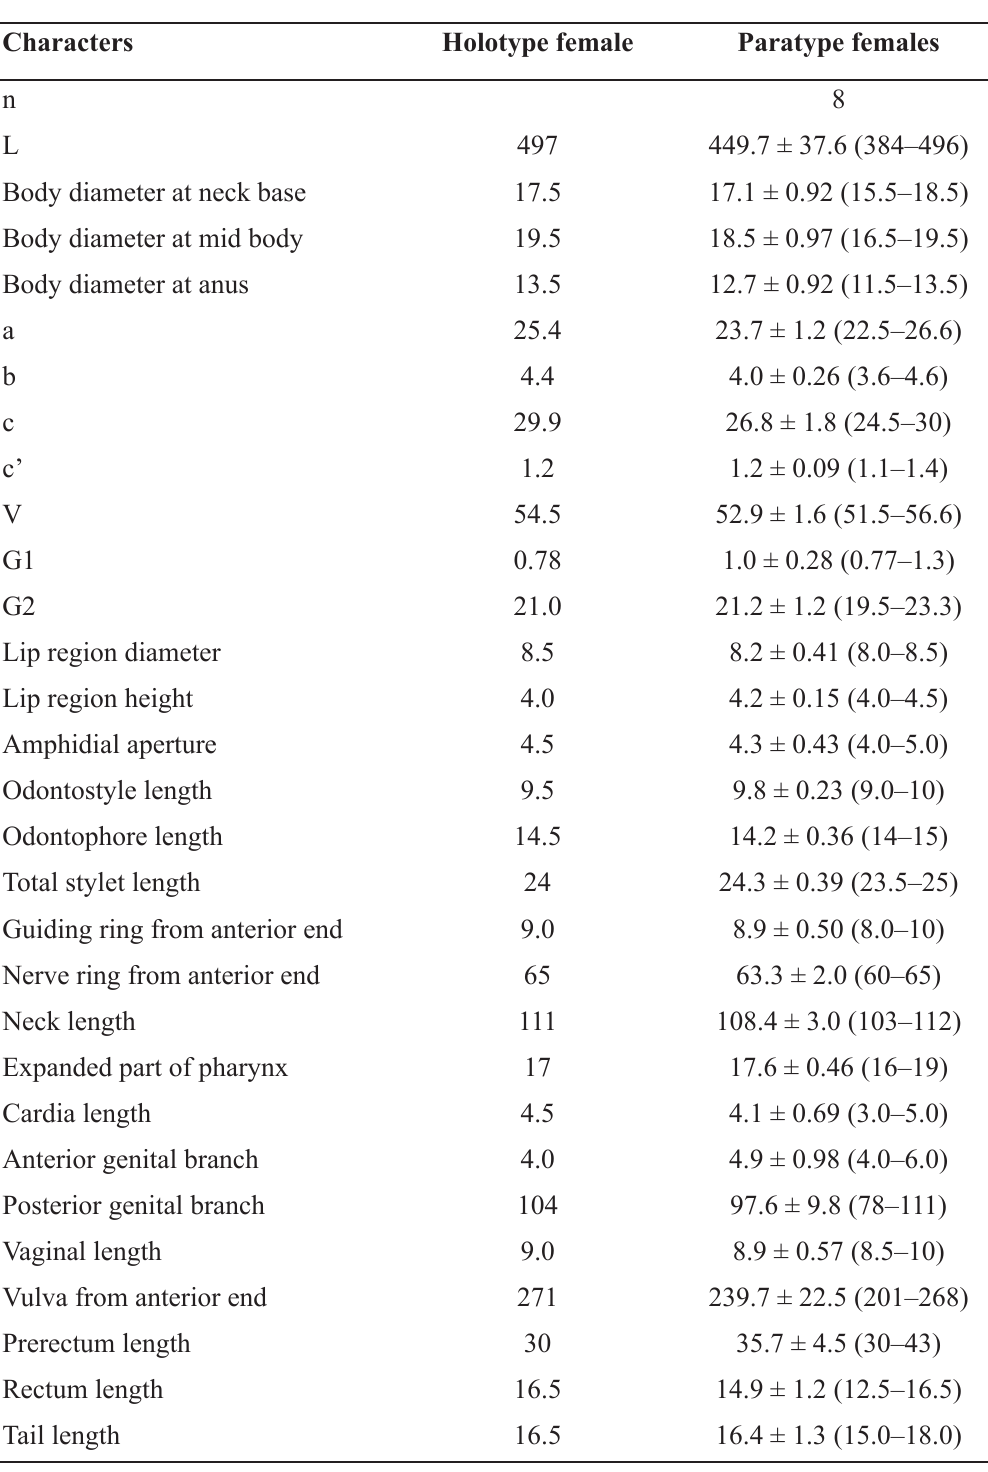
Table 8. Measurements of Basirotyleptus constrictus sp. nov. All measurements are in μm and in the form: mean ± s.d.